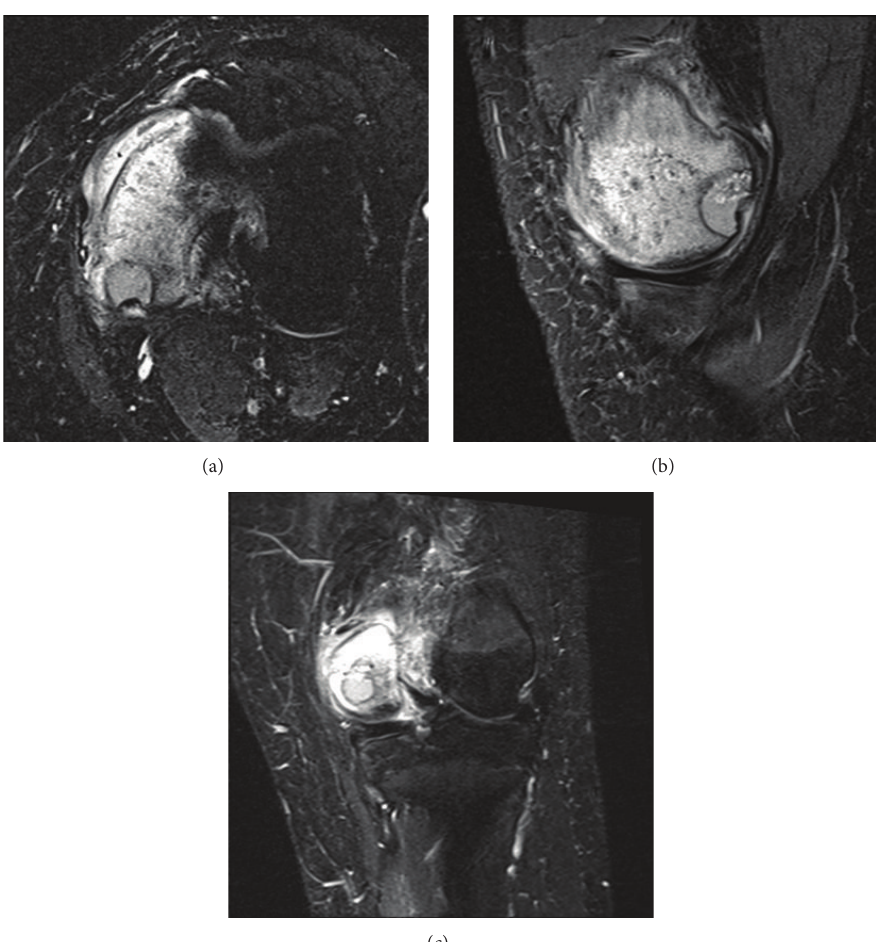
Figure 4: STIR axial (a), sagittal (b), and coronal (c) images demonstrating associated medial femoral condyle marrow edema and adjacent soft tissue edema and joint